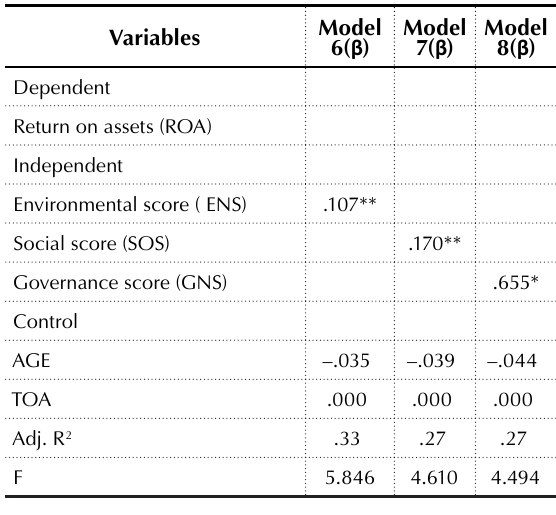
Table 5. Results of the regression analysis for environment, social and governance as independent variables and total asset as a proxy for